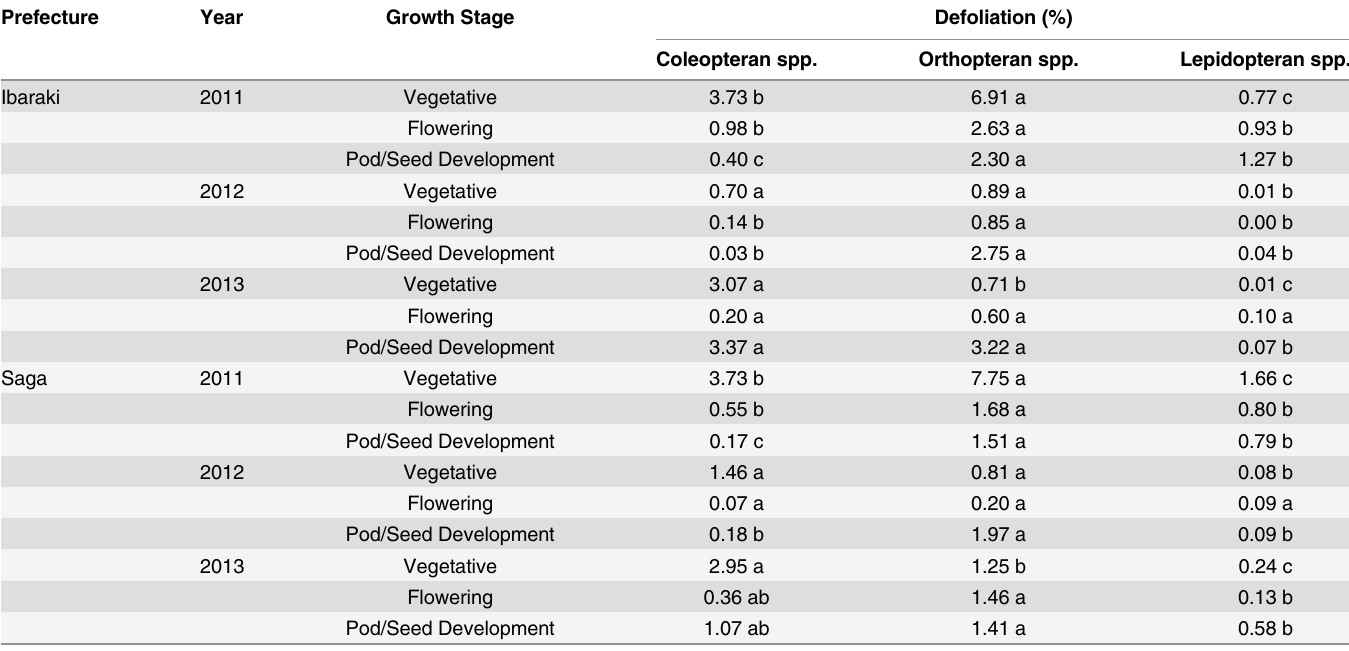
Table 3. Comparisons of three major herbivore groups feeding on wild soybean. Prefecture